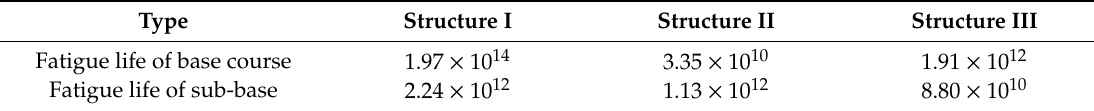
Table 9. Fatigue life of the three pavement structures (unit: times /